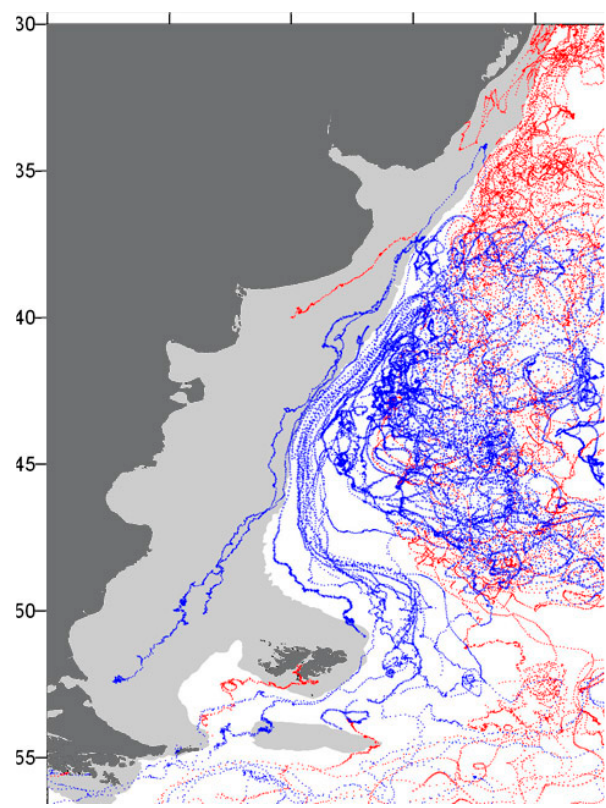
Fig. 14. Trajectories of satellite tracked “surface” drifters from WOCE-Surface Velocity Program type. The drifters are drogued to 15m depth and designed to follow the water to within ± 013ms − 1 in 10ms − 1 winds (Niiler et al., 1995). The original position data have been quality controlled and optimally interpolated to uniform six-hour interval trajectories (Hansen and Poulain, 1996). Note the quasi-linear trajectoriesof the drifters in the MC.